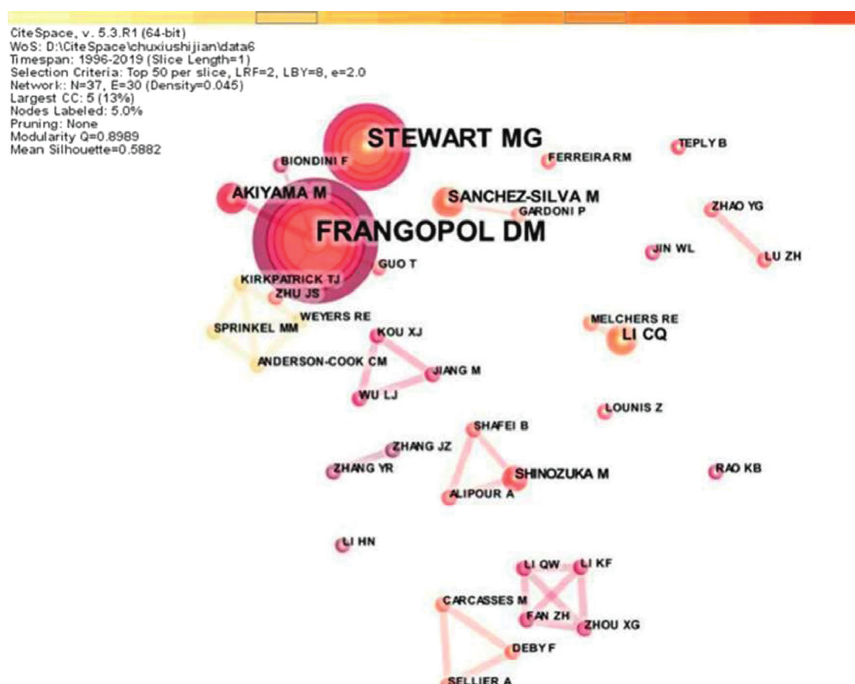
Figure 6: Coauthorship network.